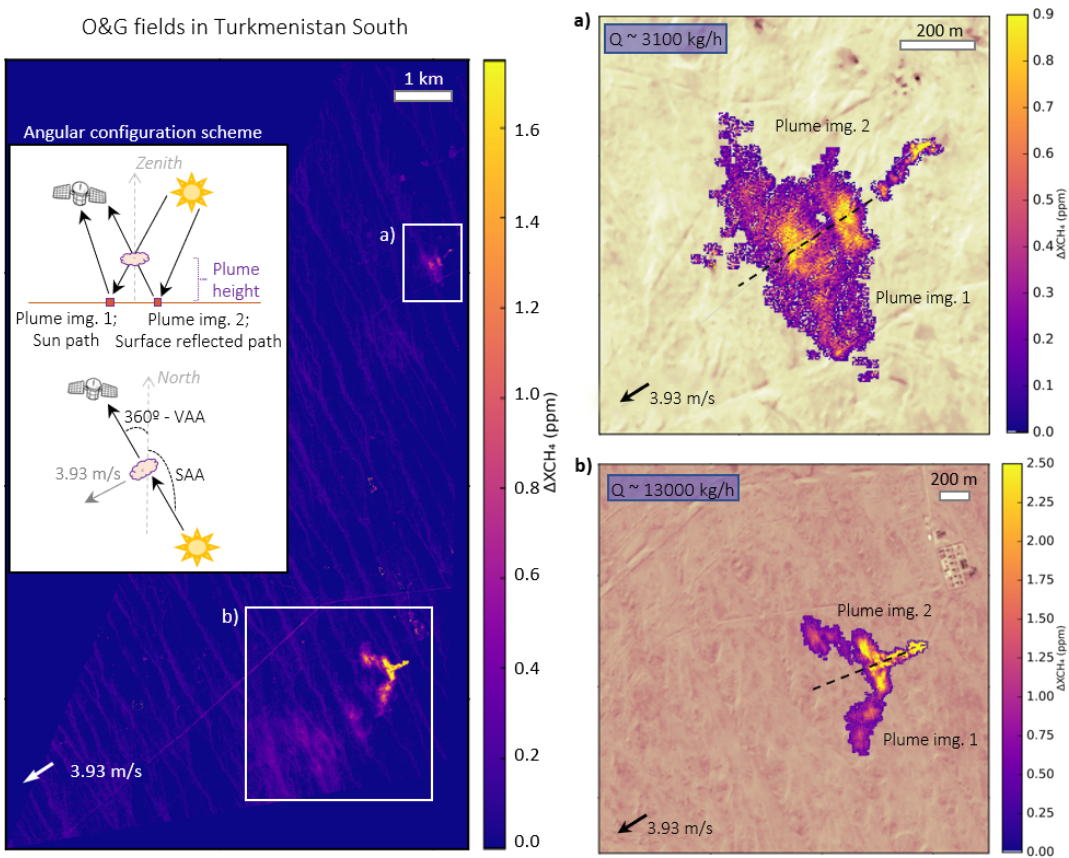
Figure 11. (cid:49) XCH 4 map produced from the real image of Turkmenistan South; Korpezhe O&G field on 29 March 2021 where two emissions are detected following a particular dual-plume structure consequence of the angular configuration on that day shown in the left diagram. Zoom panels on the right show the plumes over band 1 of the © WV-3 SWIR image used as a background. The plumes in (a) and (b) come from two different ground flares located respectively in coordinates 38.557 ◦ N, 54.200 ◦ E; and 38.494 ◦ N, 54.198 ◦ E.